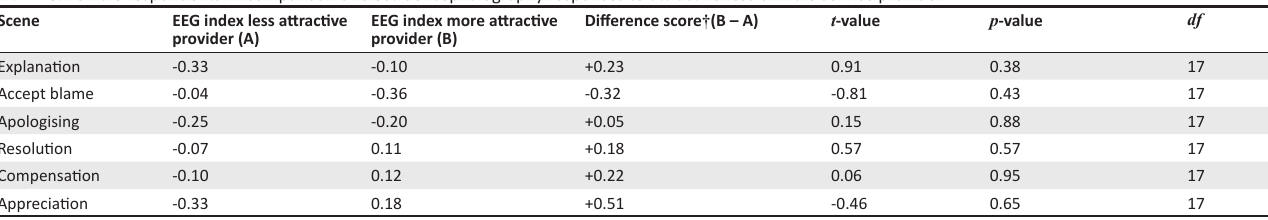
TABLE 8: Female respondents: A comparison of electroencephalography responses to attractiveness of male service provider.